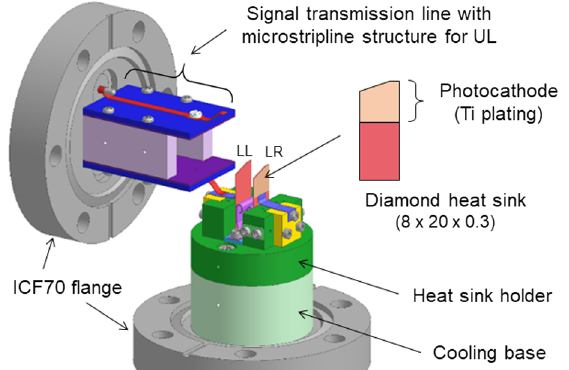
FIG. 2. Diagram of the six-way cross chamber with a couple of detector holders mounted on the top and bottom ports and a couple of signal transmission lines mounted on the left and right